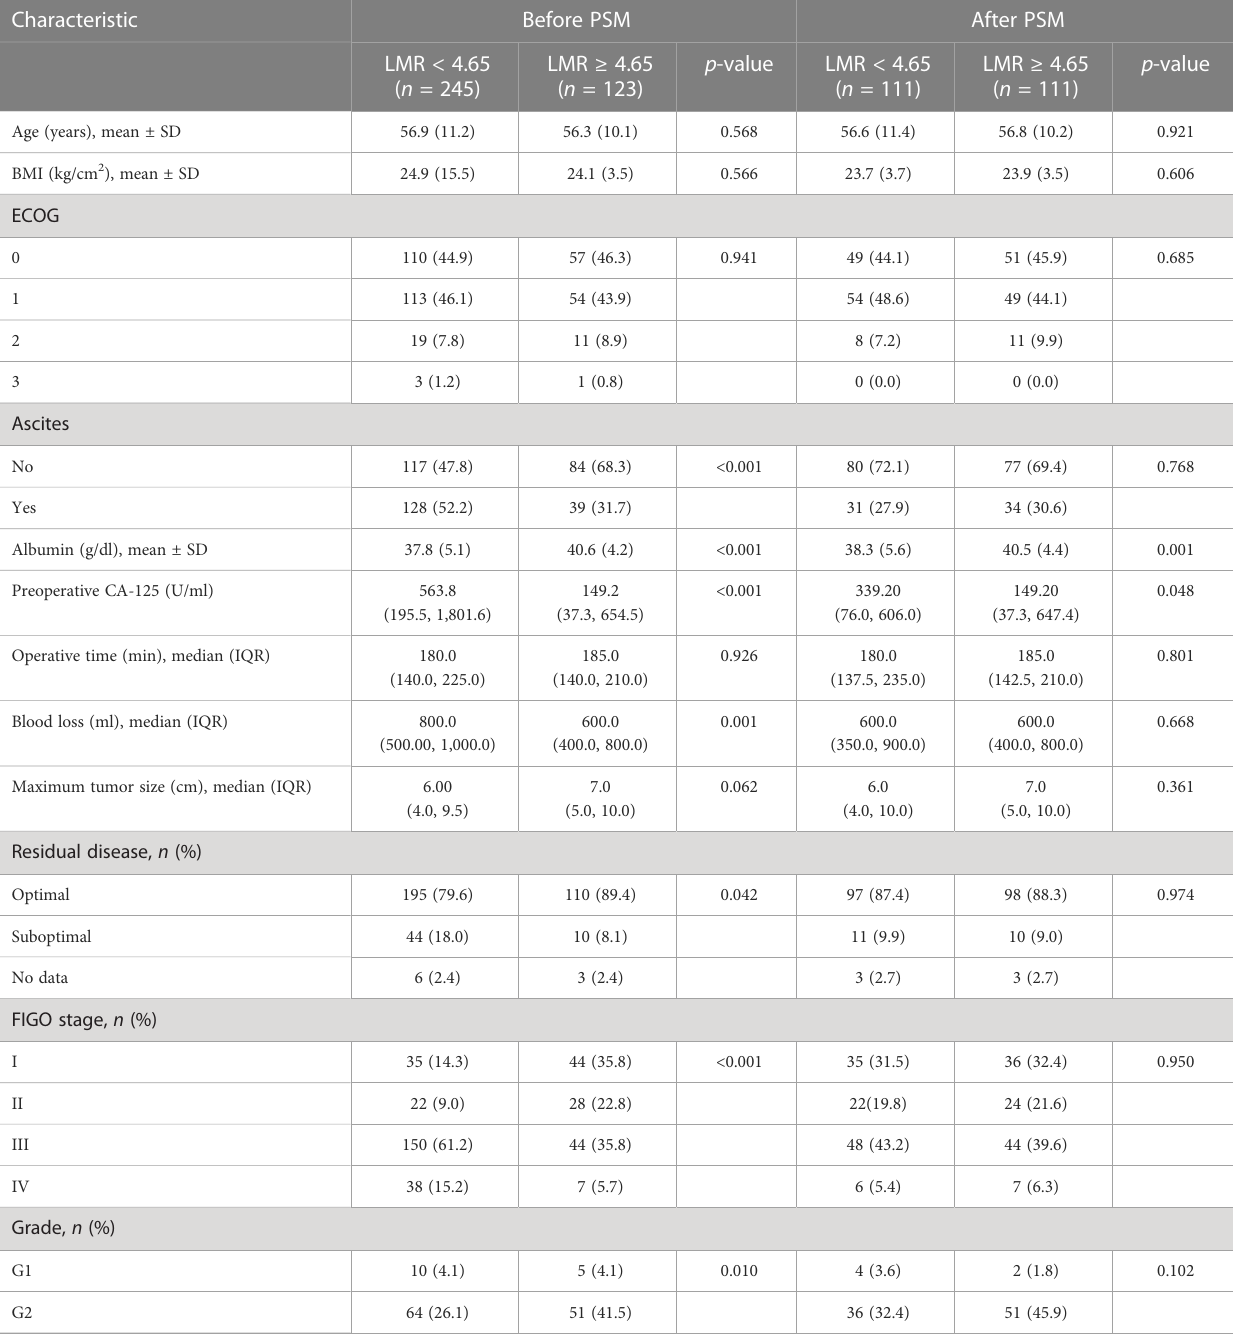
TABLE 1 Demographics and pathological characteristics of patients in each group before and after propensity score matching. Characteristic Before PSM After